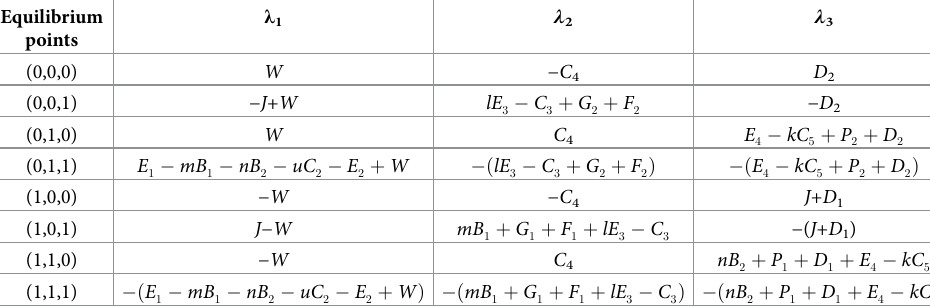
Table 3. Eigenvalues of equilibrium